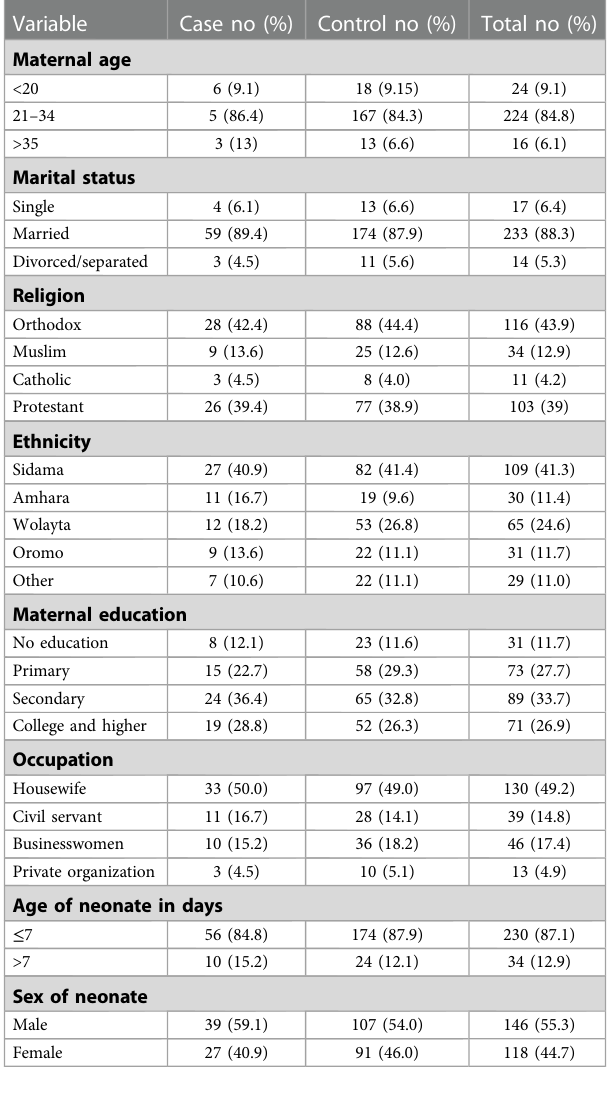
TABLE 1 Socio-demographic characteristics of cases and controls attending Hawassa University Comprehensive Specialized Hospital and Adare General Hospital, Hawassa city, Ethiopia,